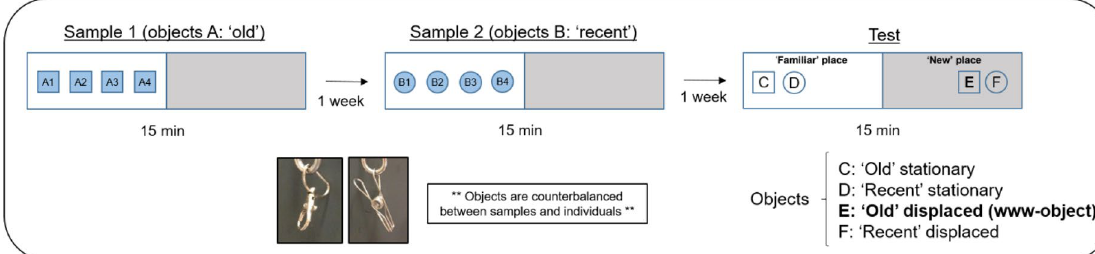
Figure 1. Experimental design. Animals were exposed to three different trials: sample 1, sample 2 and test; each lasting 15 min and with 1-week inter-trial interval. Two distinct sets of identical objects were presented